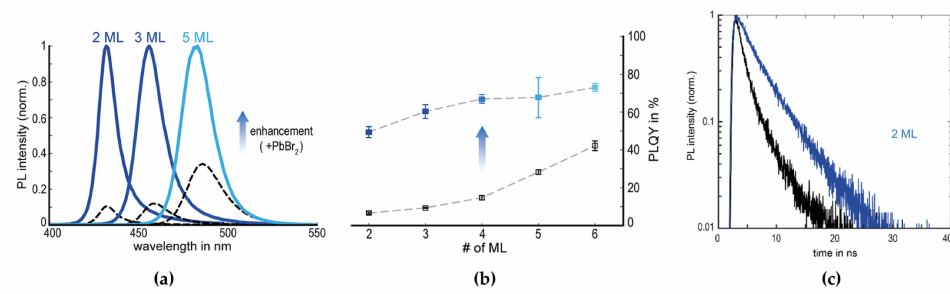
Figure 11. ( a ) PL spectra of initial NPL dispersions (dashed lines) and enhanced dispersions (solid lines). ( b ) PLQYs of the NPL dispersions with respect to numbers of monolayers (ML) for pre- enhancement (open black squares) and post-enhancement (full blue squares). ( c ) PL decay curves of initial (black lines) and enhanced (blue lines) NPLs. Reprinted with permission from [82], Copyright 2018 American Chemical